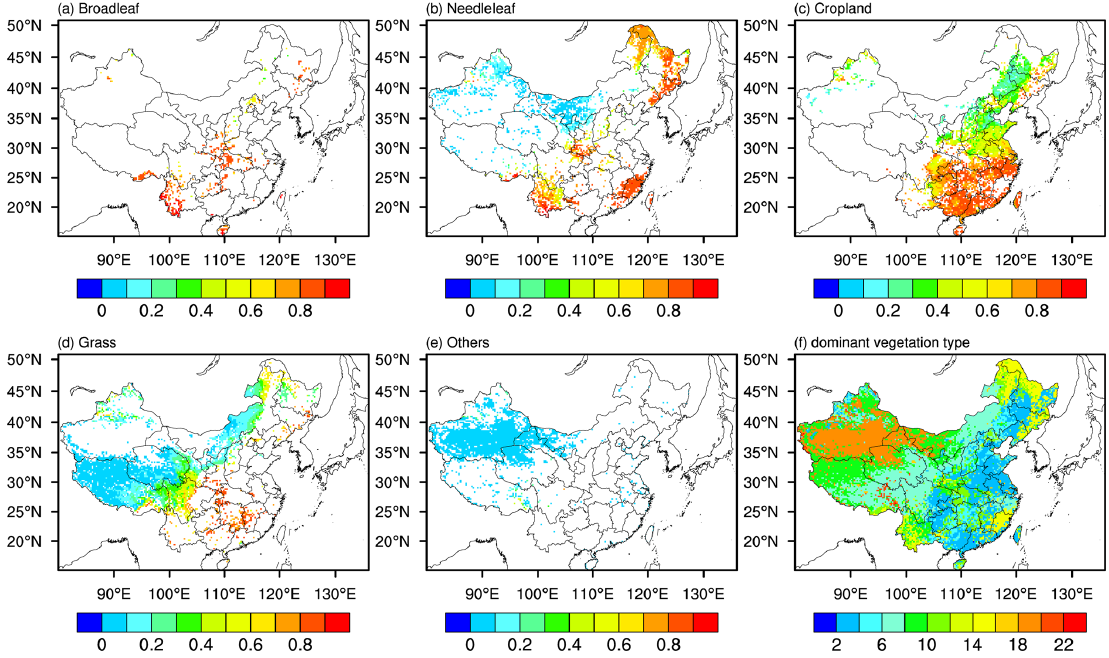
Figure 1. The vegetation fraction of (a) broadleaf, (b) needleleaf, (c) cropland, (d) grass, (e) others, and (f) dominant vegetation